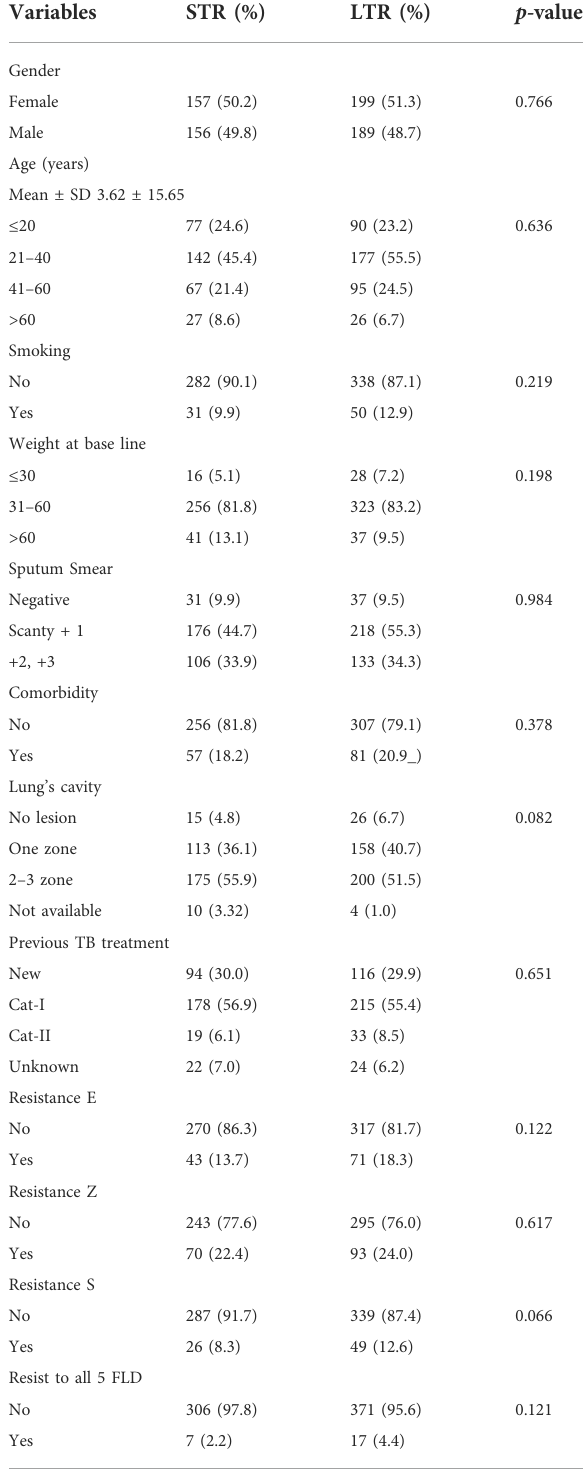
TABLE 1 Patients ’ baseline socio-demographic and clinical characteristics N =